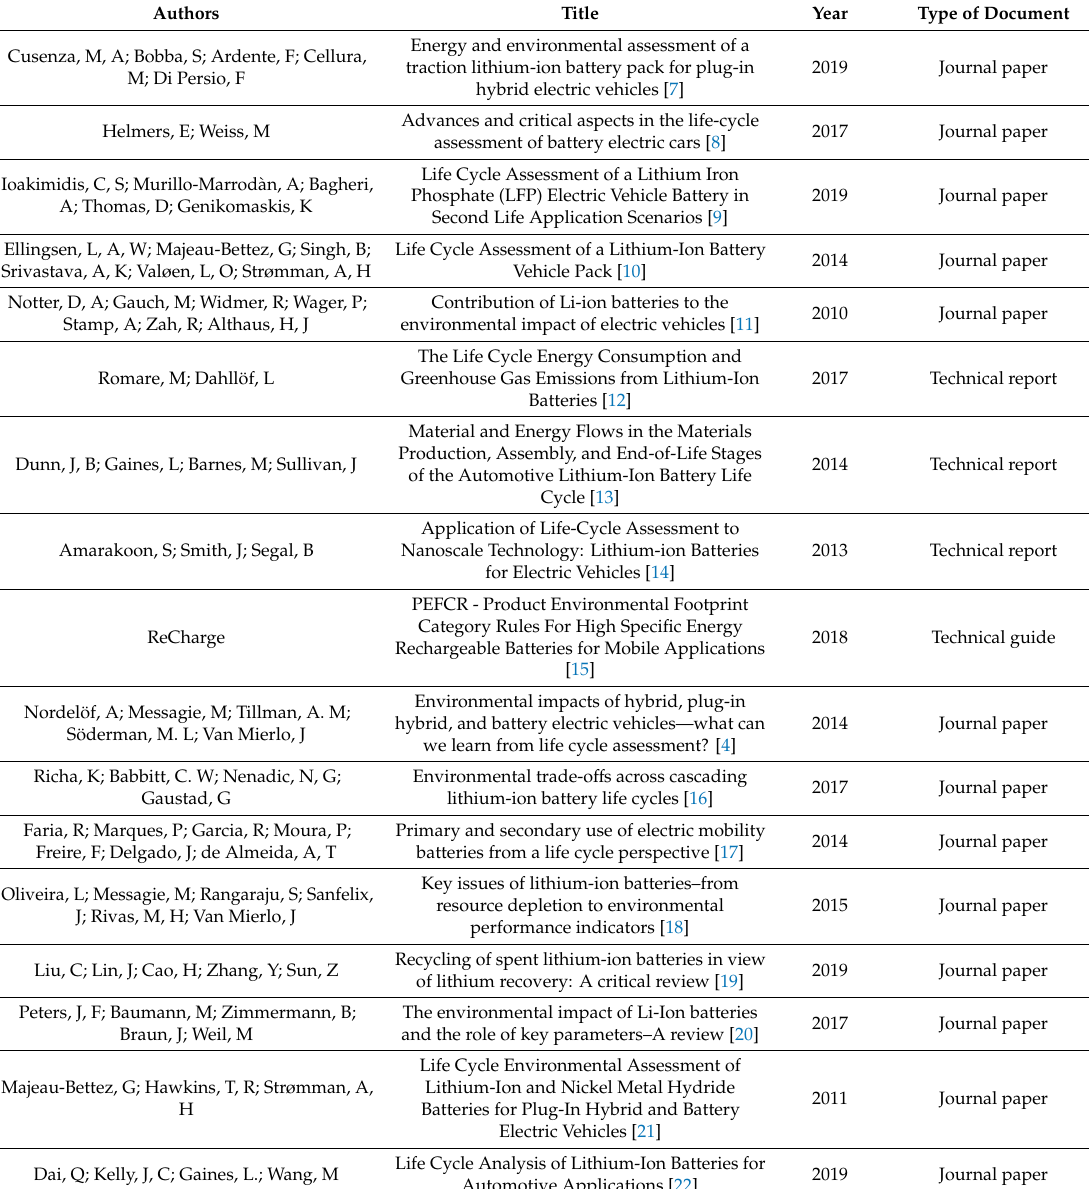
Table 2. Documents analyzed within this bibliographic